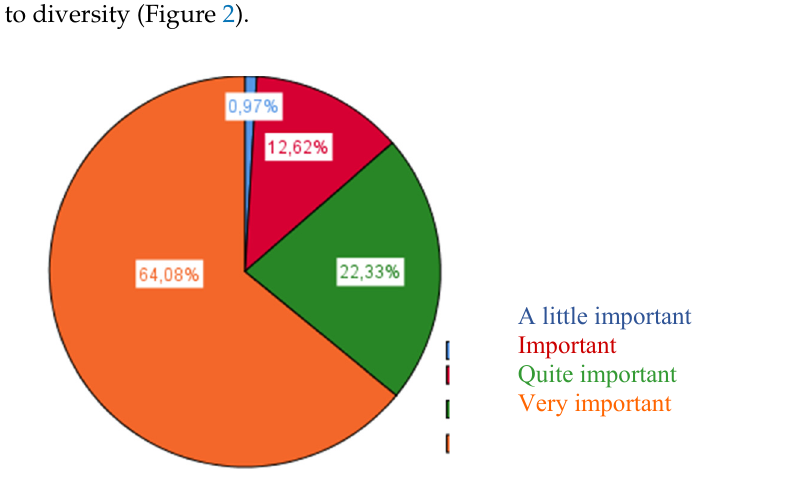
Figure 2. Potential for interaction with families or tutors.